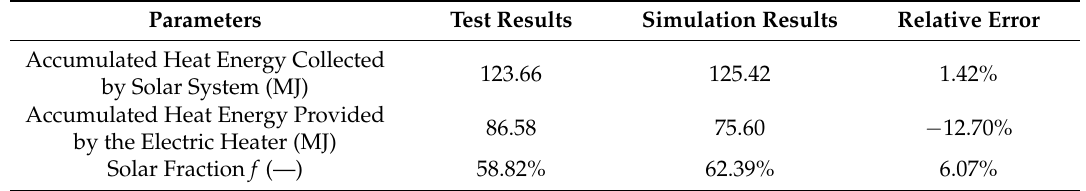
Table 5. Comparison of the simulation results and field test data of the system thermal performance.